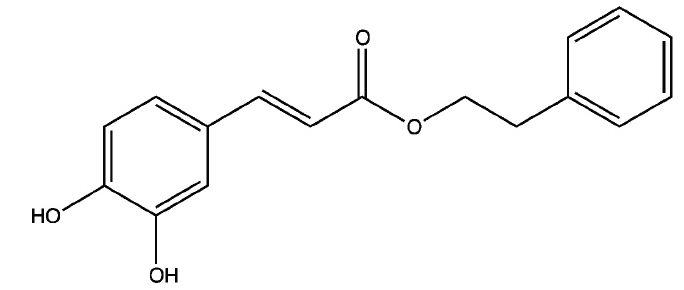
Figure 1. Structure of caffeic acid phenethyl ester